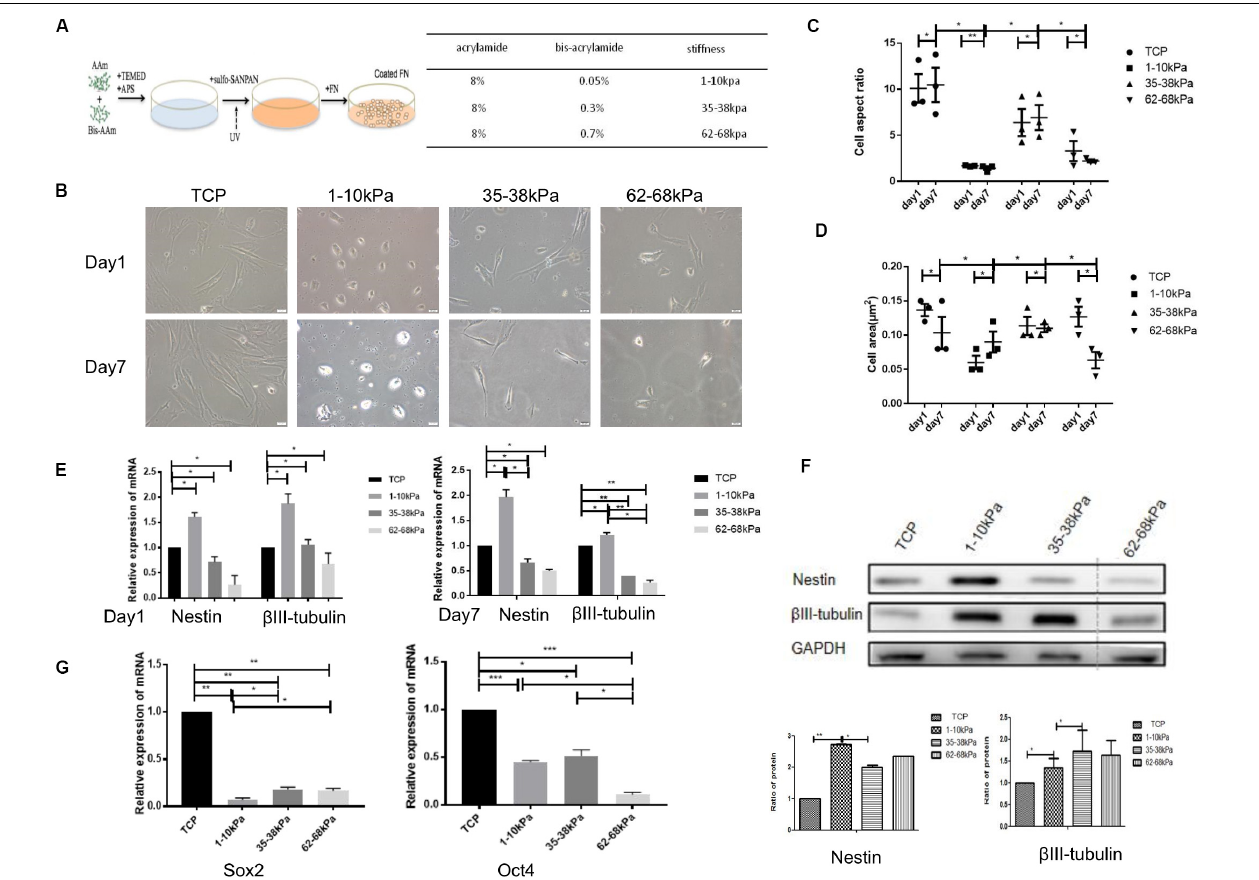
FIGURE 1 | Matrix stiffness regulates cell morphology and neural differentiation ofhuman umbilicalcordmesenchymal stem cells (hUC-MSCs). (A) A summary of substrate stiffness construction. Matrixes of different stiffness were prepared by mixing the same concentration of acrylamide (AAm) with different concentrations of bis-acrylamide (Bis-AAm; 0.05, 0.3, and 0.7%). Sulfo-SANPAH (hexanoate) was cross-linked via ultraviolet irradiation and then coated with fibronectin for cell adhesion. (B) Matrix stiffness affects the morphological characteristics of hUC-MSCs. Morphological characteristics of hUC-MSCs were observed under a scanning electron microscope at days 1 and 7. TCP group: cells on Tissue Culture Plate. Scale bar = 20 µ m. n = 3 independent wells. (C) The cell aspect ratio was calculated using NIH Image J. The aspect ratio of the cell is the ratio of the major to minor axes ( n = 3, * p < 0.05,and ** p < 0.01). (D) The cell area was calculated using NIH Image J ( n = 3, * p < 0.05,and ** p < 0.01). (E) qRT-PCR analyses were performed to detect the expression of neuronal-specific markers Nestin and β III-tubulin in hUC-MSCs at day 1 and day 7 (Results are presented as mean ± SEM, n = 5 independent experiments, * p < 0.05, and ** p < 0.01). (F) Western blotting analysis of Nestin and β III-tubulin at day 7 (Results are presented as mean ± SEM, n = 3, * p < 0.05, and ** p < 0.01). (G) qRT-PCR analysis of stem cells self-renewal markers SOX2 and OCT4 at day 1 (Results are presented as mean ± SEM, n = 5 independent experiments, * p < 0.05, ** p < 0.01, and *** p <